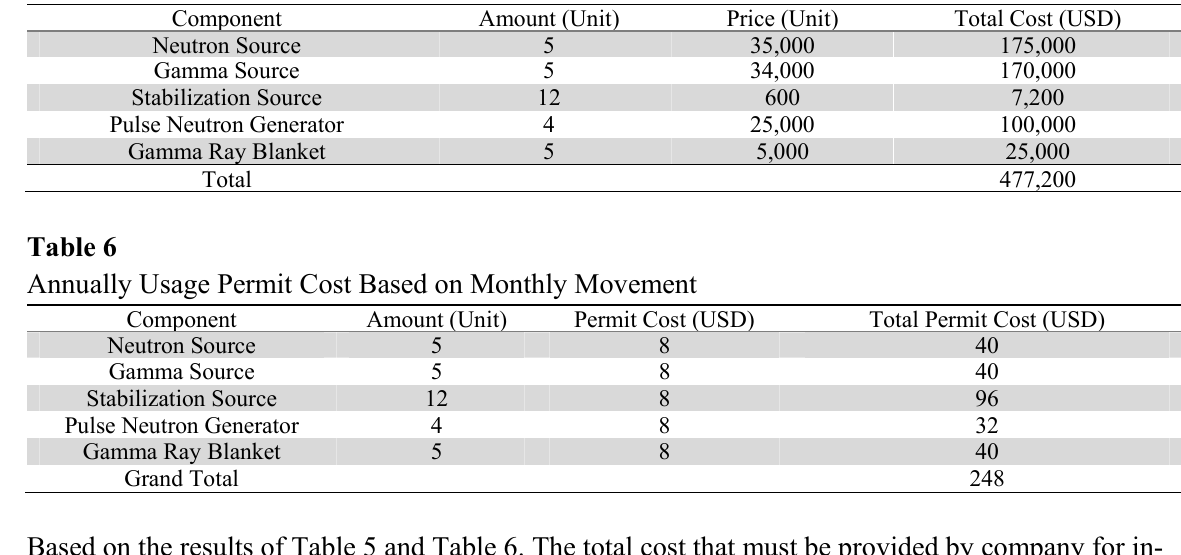
Monthly Needs for Radioactive Source and Components